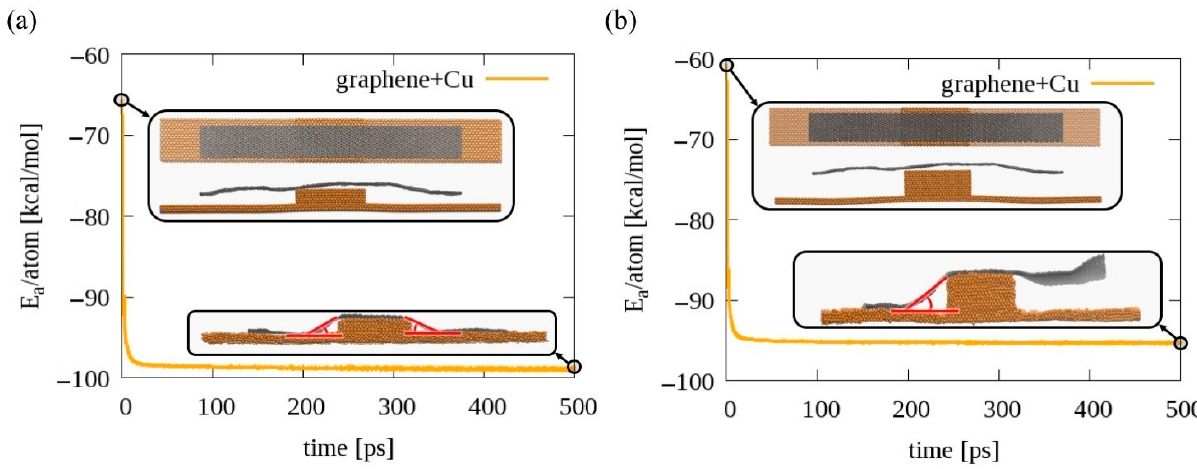
Figure 4. The graphene ribbon at the copper steps. Time evolution of potential energy for a graphene ribbon of length 40 nm placed at the top of copper surfaces with ( a ) 6 Cu layer and ( b ) 12 Cu layer step edges. Insets at the top of both graphs show the initial structure for the ribbon, top and side view. Insets at the bottom of both graphs show the final configurations for the considered systems. Orange/grey spheres indicate Cu/C atoms, respectively.